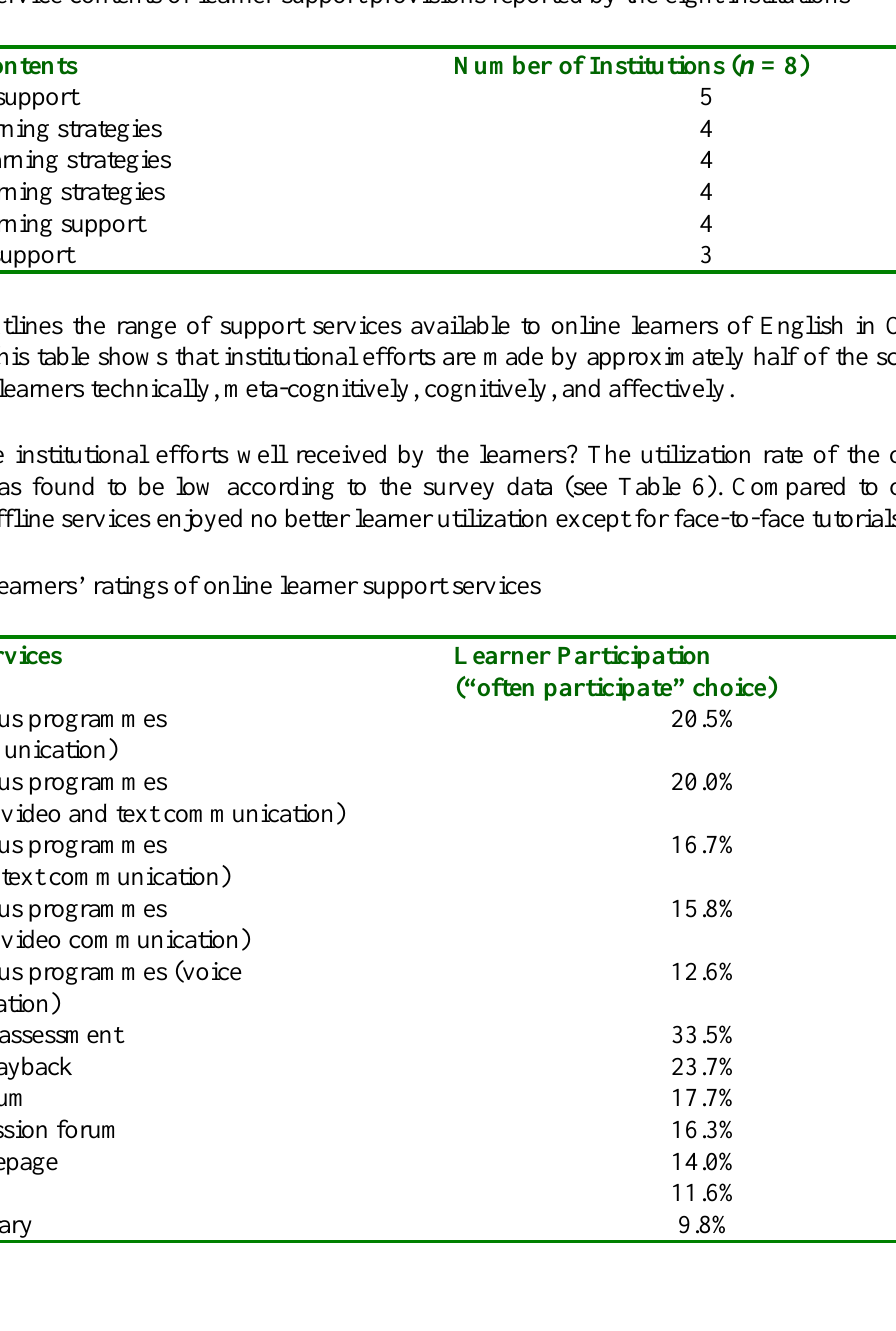
Table 5. Service contents of learner support provisions reported by the eight institutions